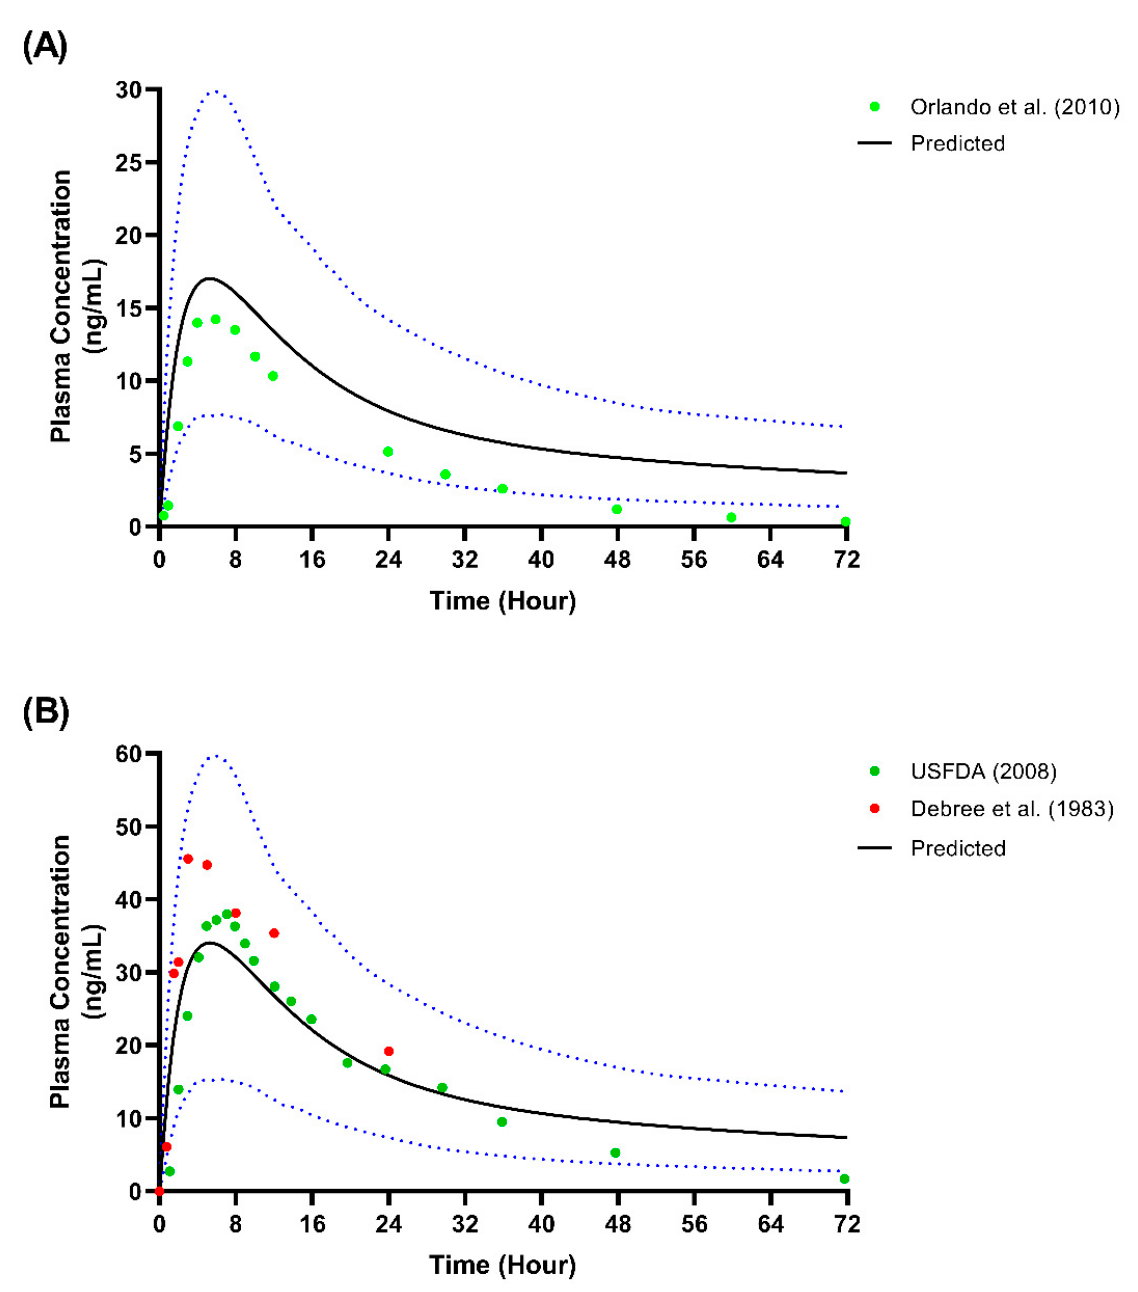
Figure 4. Single-dose studies simulated in model validation stage. ( A ) Single-dose 50 mg [44]; ( B ) Single-dose 100 mg [45,46]. Solid lines represent the mean predicted concentration-time profile, with dotted lines representing the 5th and 95th percentile ranges. Solid circles represent observed clinical data from each study.